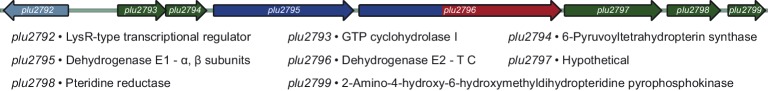
The pepteridine biosynthetic locus.Green, pteridine synthesis genes; Blue, pyruvate dehydrogenase-like genes; Red, NRPS-like genes. T, thiolation domain; C, condensation domain.